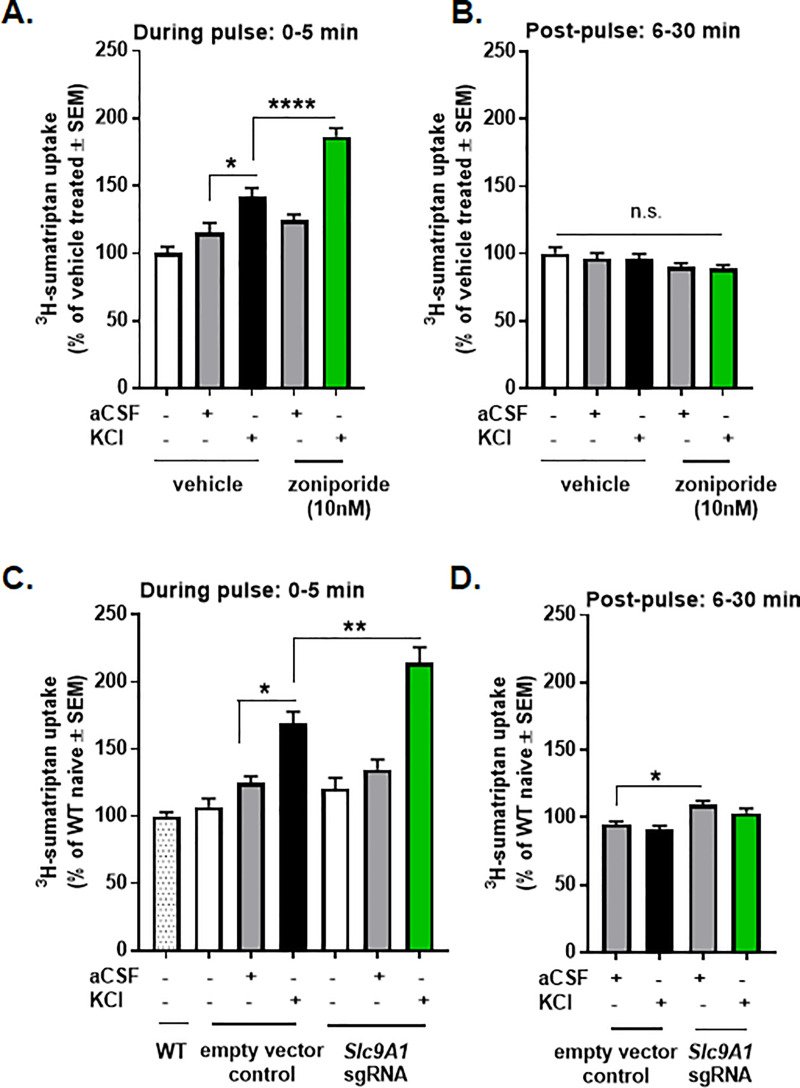
NHE1 inhibition enhanced KCl induced transport of sumatriptan in vitro.(A) 3H-sumatriptan uptake during a 5 min KCl or aCSF pulse with or without pretreatment of zoniporide (10nM). All data represent % of vehicle treated ± SEM (n = 13–18). (B) 3H-sumatriptan uptake post-pulse with or without pretreatment of zoniporide. All data represent % of vehicle treated ± SEM (n = 11–13). (C) 3H-sumatriptan uptake during the KCl or aCSF pulse after the genetic manipulation of NHE1. All data represent % of wild-type naïve ± SEM (n = 9–13). (D) 3H-sumatriptan uptake 30 min post-pulse after the genetic manipulation of NHE1. All data represent % of wild-type naïve ± SEM (n = 9–13). * p<0.05, ** p<0.01, **** p<0.0001 as assessed by one-way ANOVA. n.s. = non-significant.